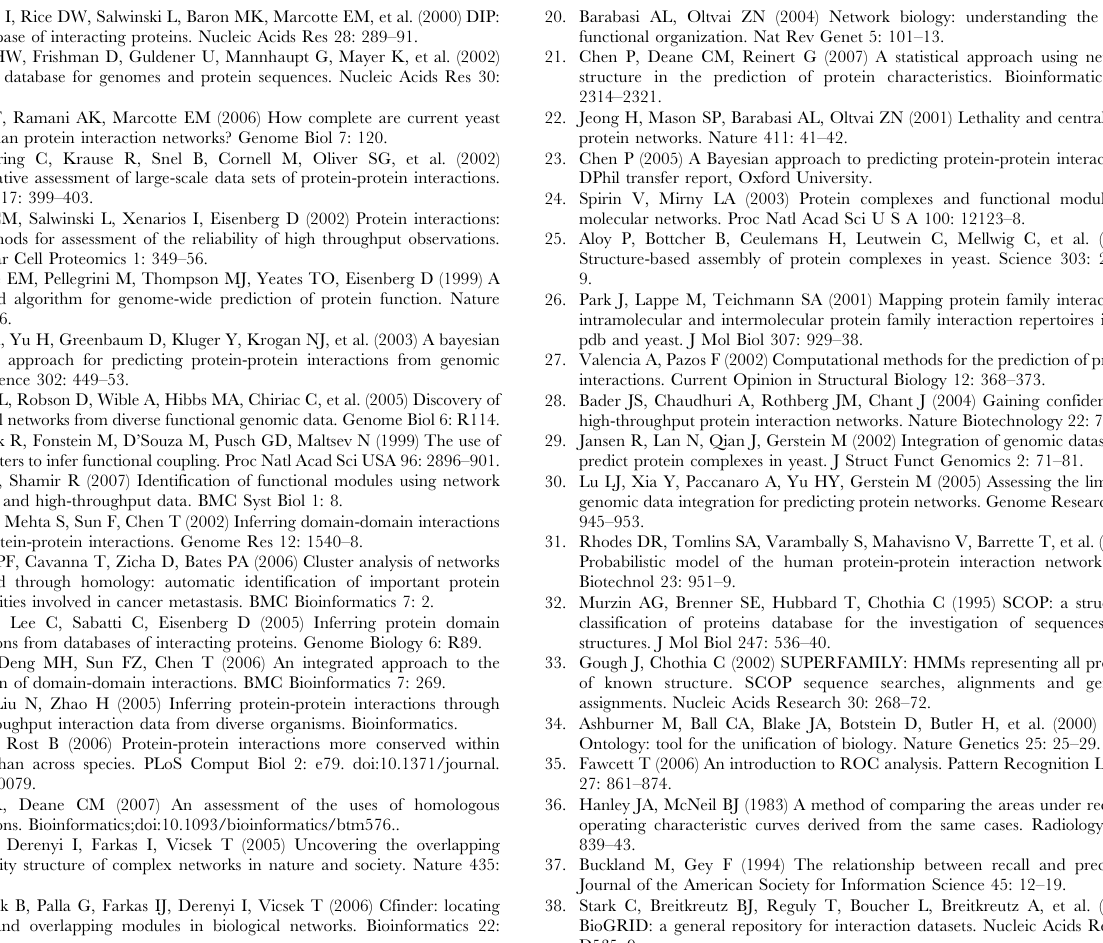
Table S1 Estimates of r-bar from characteristic triplets